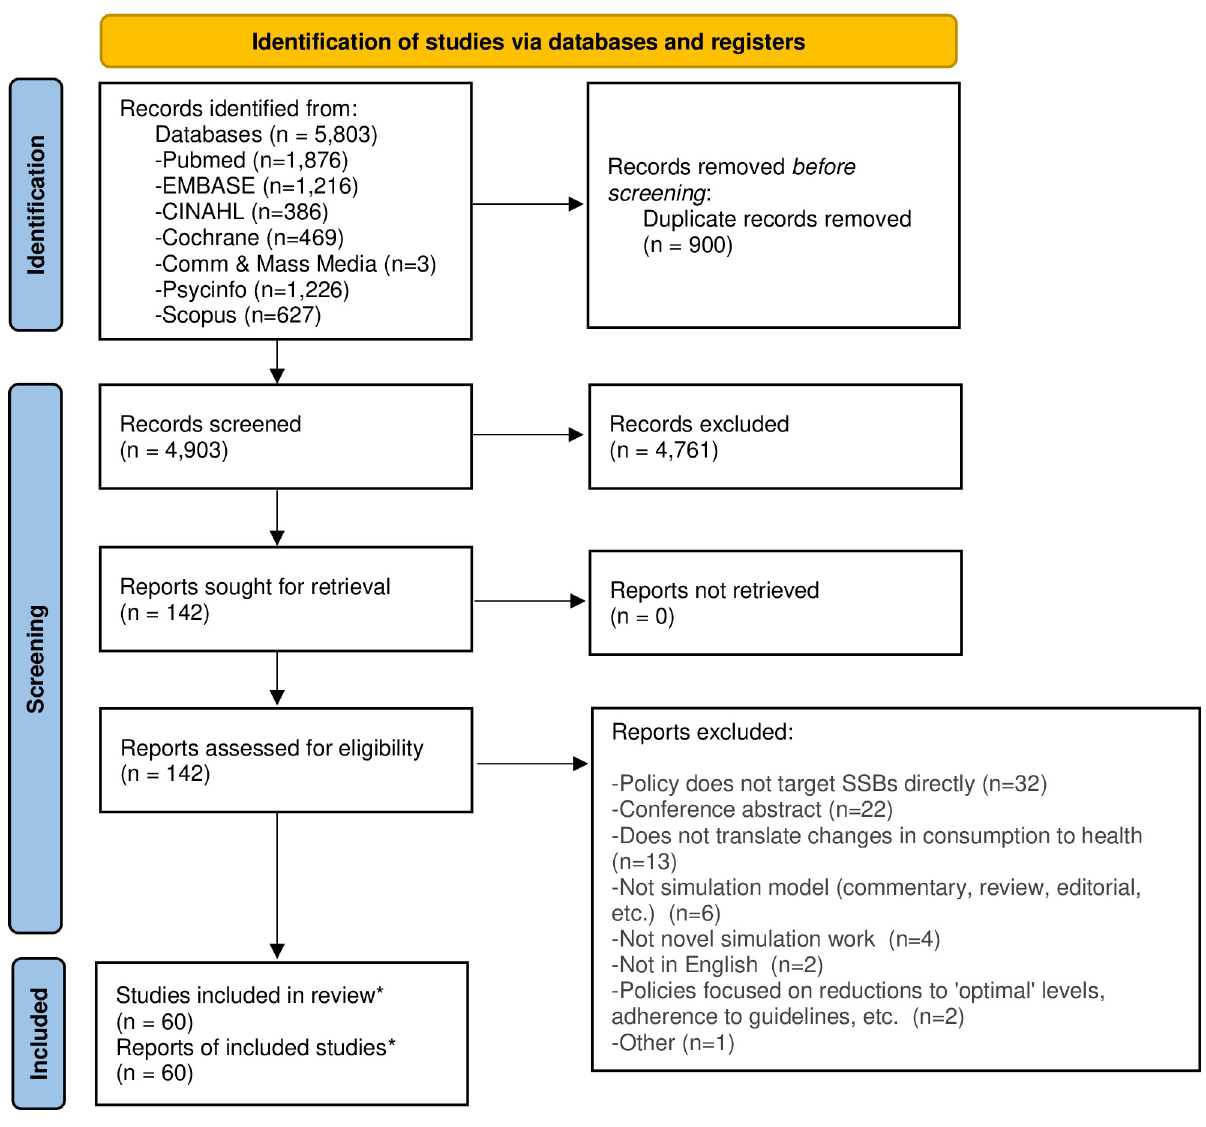
Fig 1. PRISMA 2020 flow diagram for new systematic reviews. Notes: � An additional article known to our team that was not picked up by search terms because it did not have an abstract was added after identification of articles via registers and databases, bringing the final number of studies included to